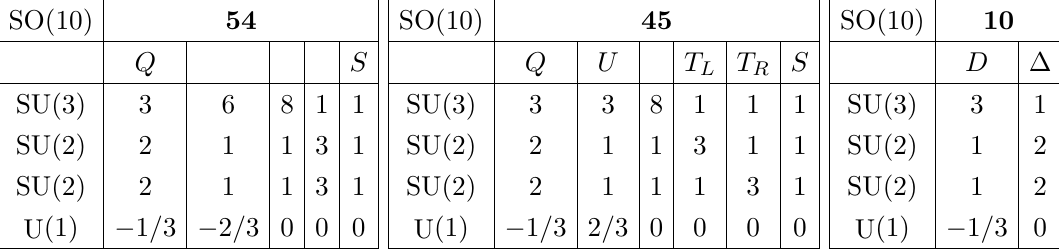
Table 2 . Decomposition of X states into representations of 3221. For complex representations, complex conjugations of them are